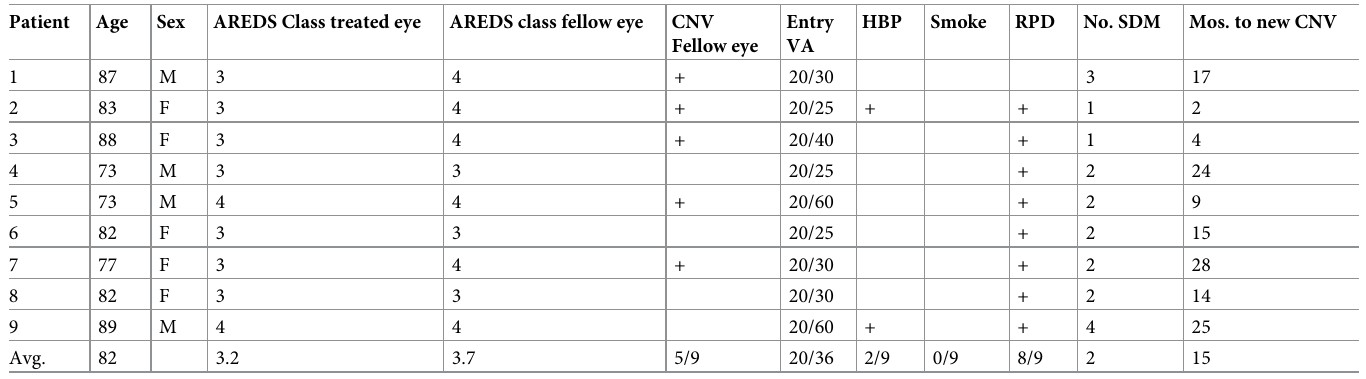
Table 4. Characteristics of treated eyes with dry AMD developing choroidal neovascularization following